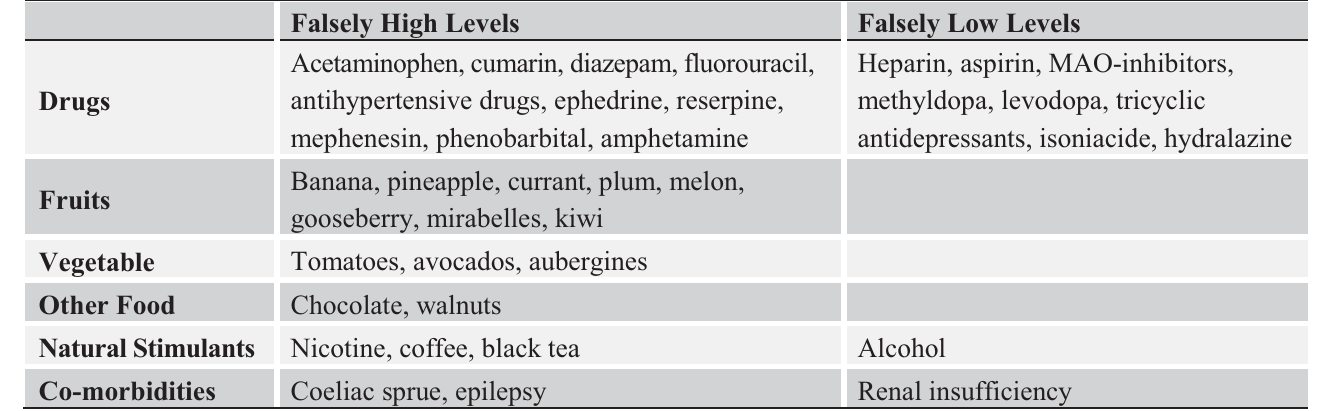
Table 12. Disturbing factors of 5-HIAA